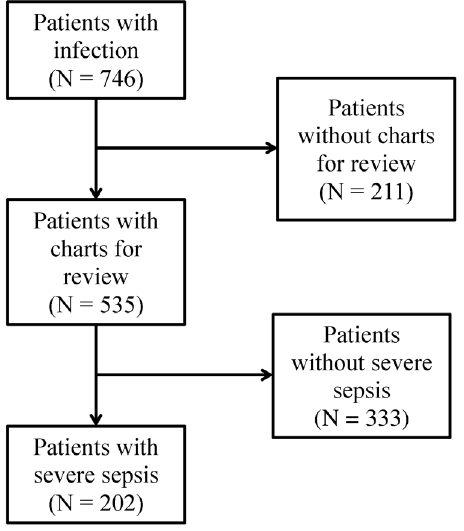
Figure 1. Flow diagram of study enrollment and analysis.